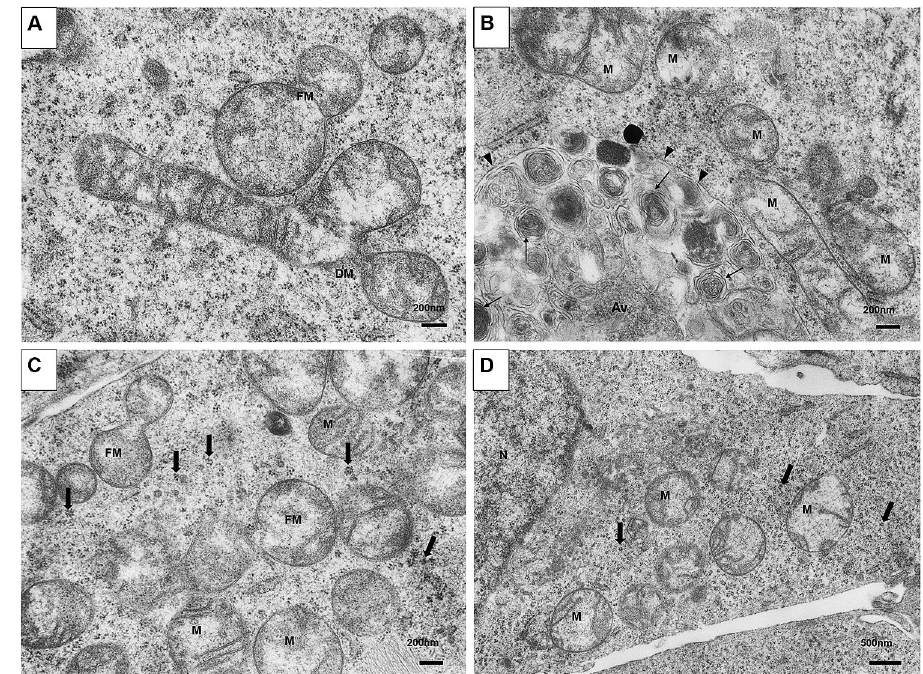
Figure 2. 2-ME induces mitochondrial fission and authophagy in osteosarcoma 143B cells. The cells were incubated in serum- and amino acid-free medium with 10 nM, 100 nM and 1 µM 2-ME for 8 h, fixed and processed for transmission electron microscopy. ( A ) 2-ME, 1 µM. Mitochondrial fussion (FM) and division of mitochondria (DM). ( B ) 2-ME, 1 µM. Very large autophagic vacuole (Av), surrounded by double membrane (arrowheads) contains numerous lamellar bodies (thin arrows); presence of many mitochondria (M). ( C ) 2-ME, 100 nM. Numerous mitochondria, mitochondrial fission (FM), abundant glycogen rosettes (thick arrows). ( D ) 2-ME, 10 nM. Abundant mitochondria and glycogen rosettes, N—cell nucleus. Magnifications: ( A – C )— 20,000×, ( D